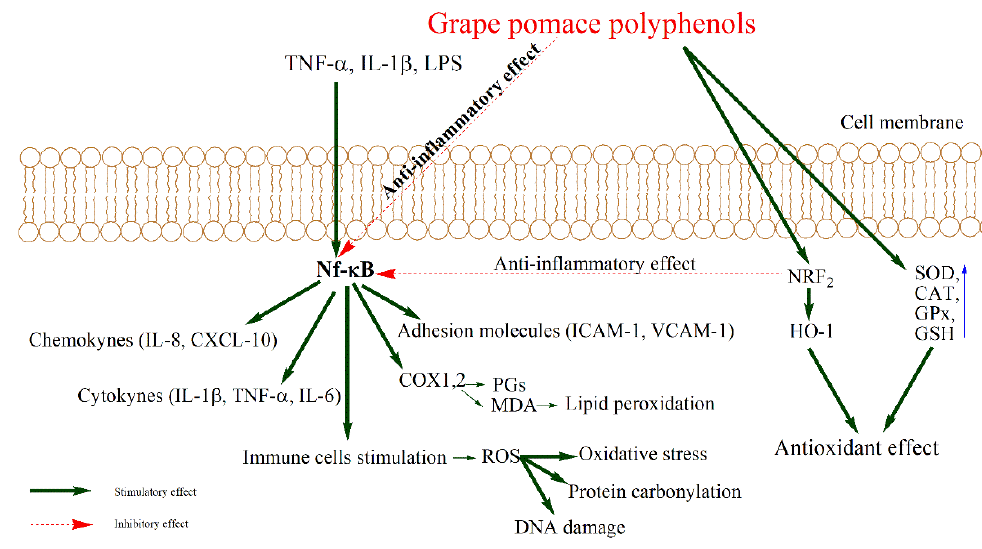
Figure 3. Proposed antioxidant and anti-inflammatory actions of polyphenols from grape pomace. Further, there are presented the in vitro and in vivo beneficial effects of different red and white GP in oxidative stress and inflammatory conditions.